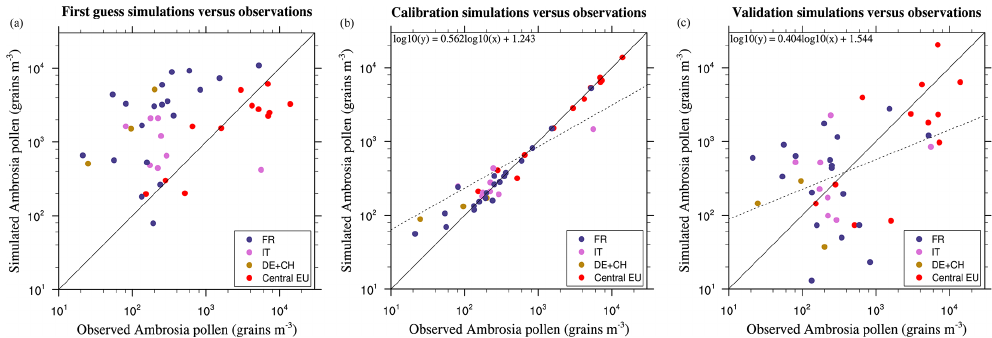
Figure 4. Average (2000–2010) annual pollen sum for first guess (a) , calibration (b) and validation (c) simulations on